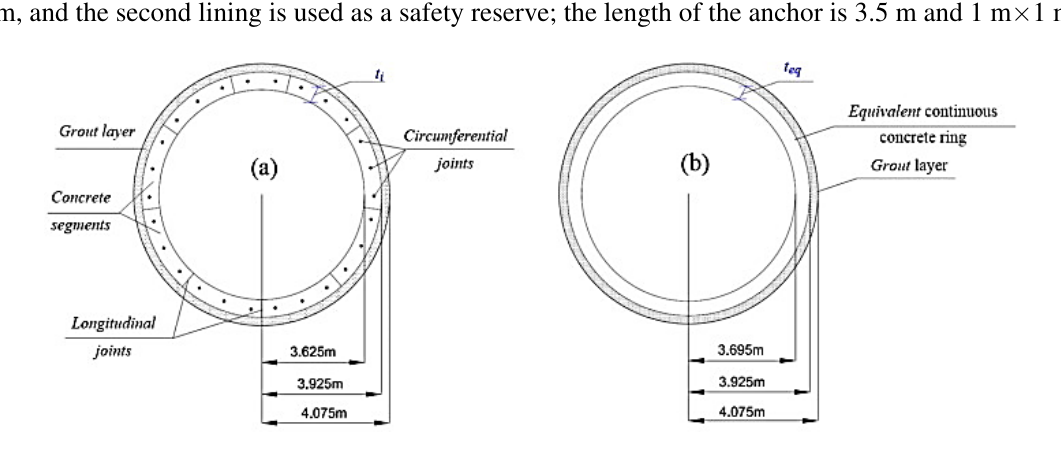
Fig. 1 Two different circular tunnel support